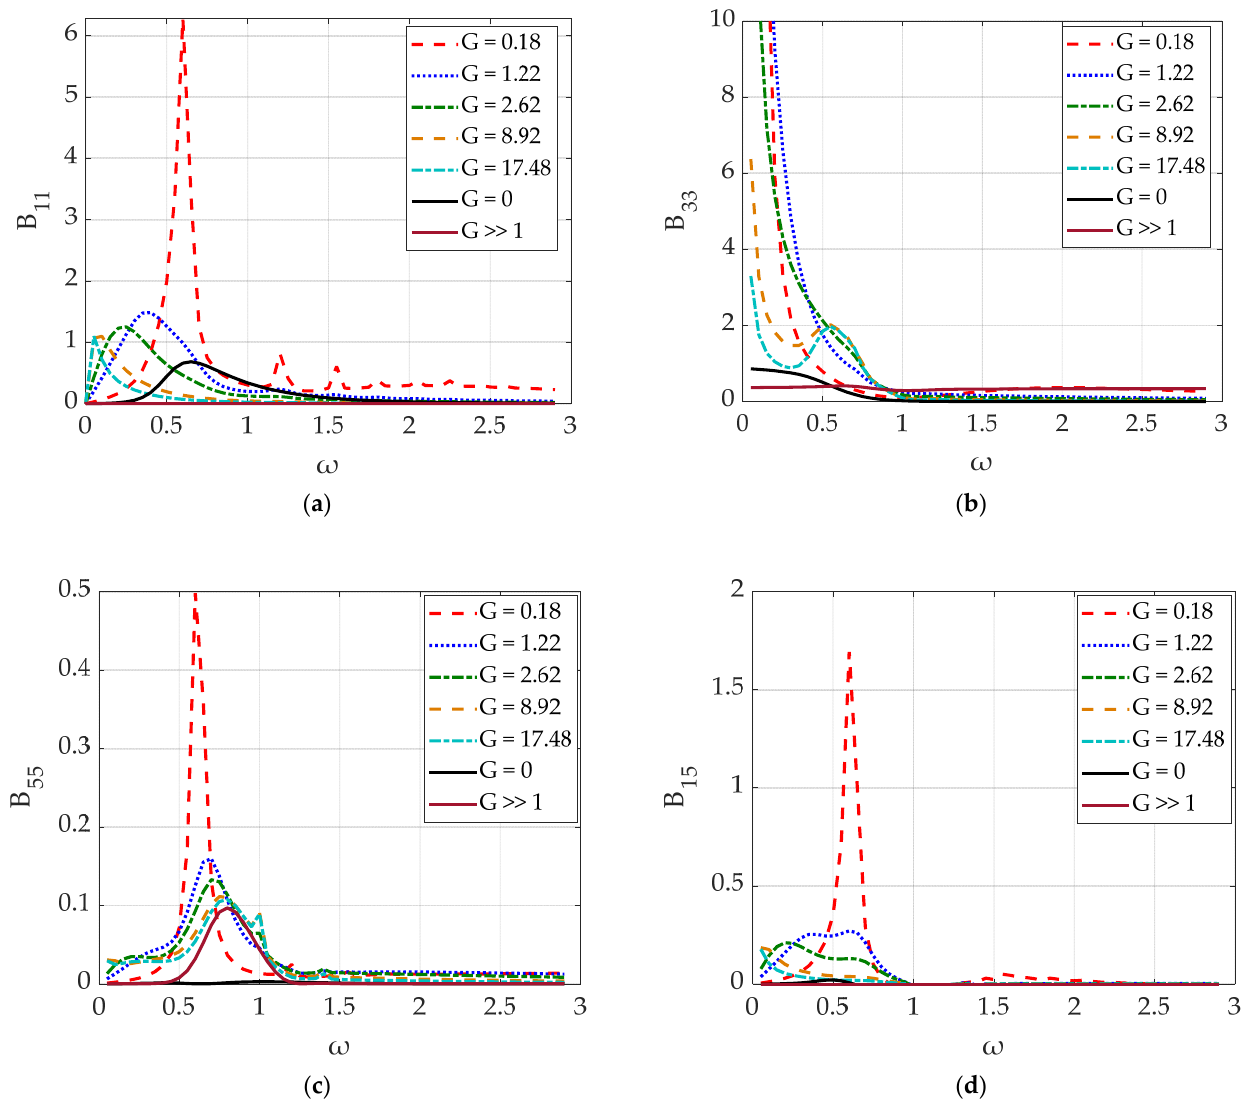
Figure 7. Dimensionless hydrodynamic damping coefficients B 11 ,B 33 , B 55 , B 15 of the permeable cylindrical body against wave frequency ω for various values of porous effect parameter: ( a ) B 11 ; ( b ) B 33 ; ( c ) B 55 ; ( d ) B 15 . The results are also compared with the corresponding ones of a truncated cylinder ( G = 0 case) and of a submerged cylindrical plate ( G (cid:29) 1